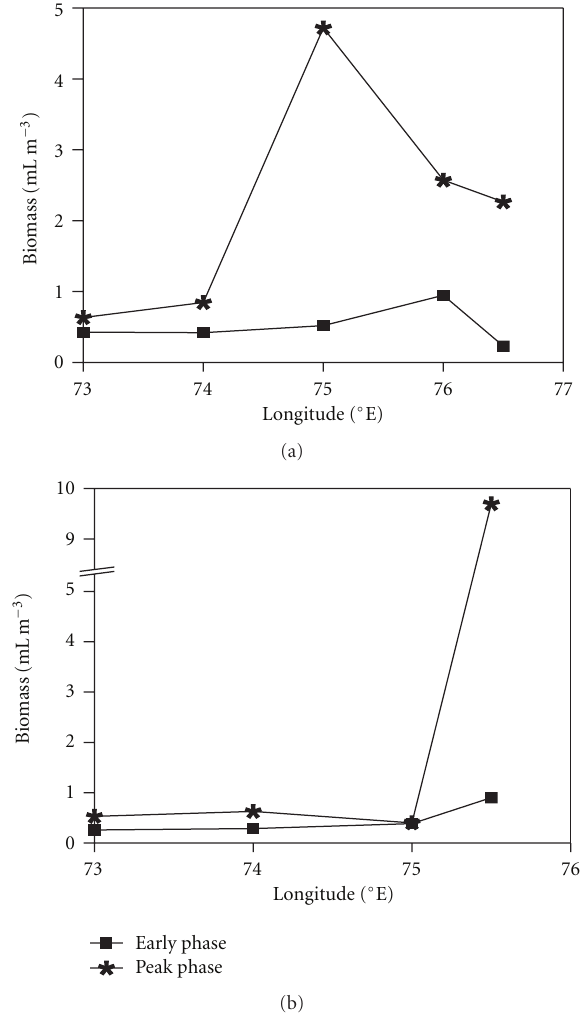
Figure 6: Mesozooplankton biomass (mLm − 3 ) from thermocline layer to the surface during early and peak phases of summer mon- soon along 8 ◦ N (a) and 10 ◦ N (b) (note: scales are not